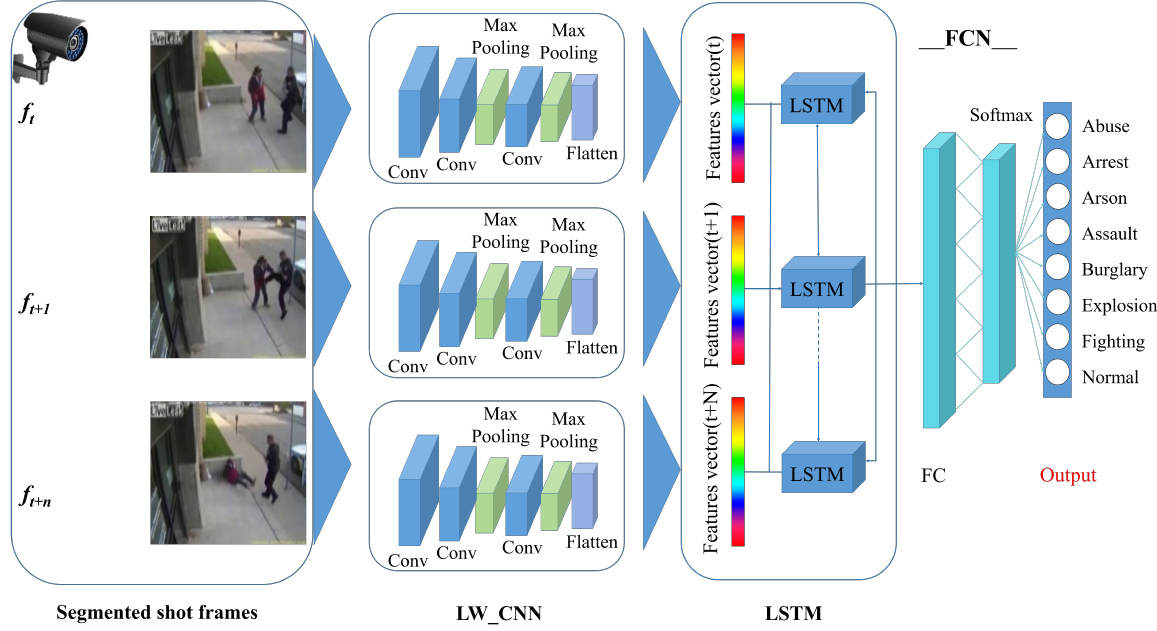
Figure 1. EADN framework for anomaly detection in surveillance